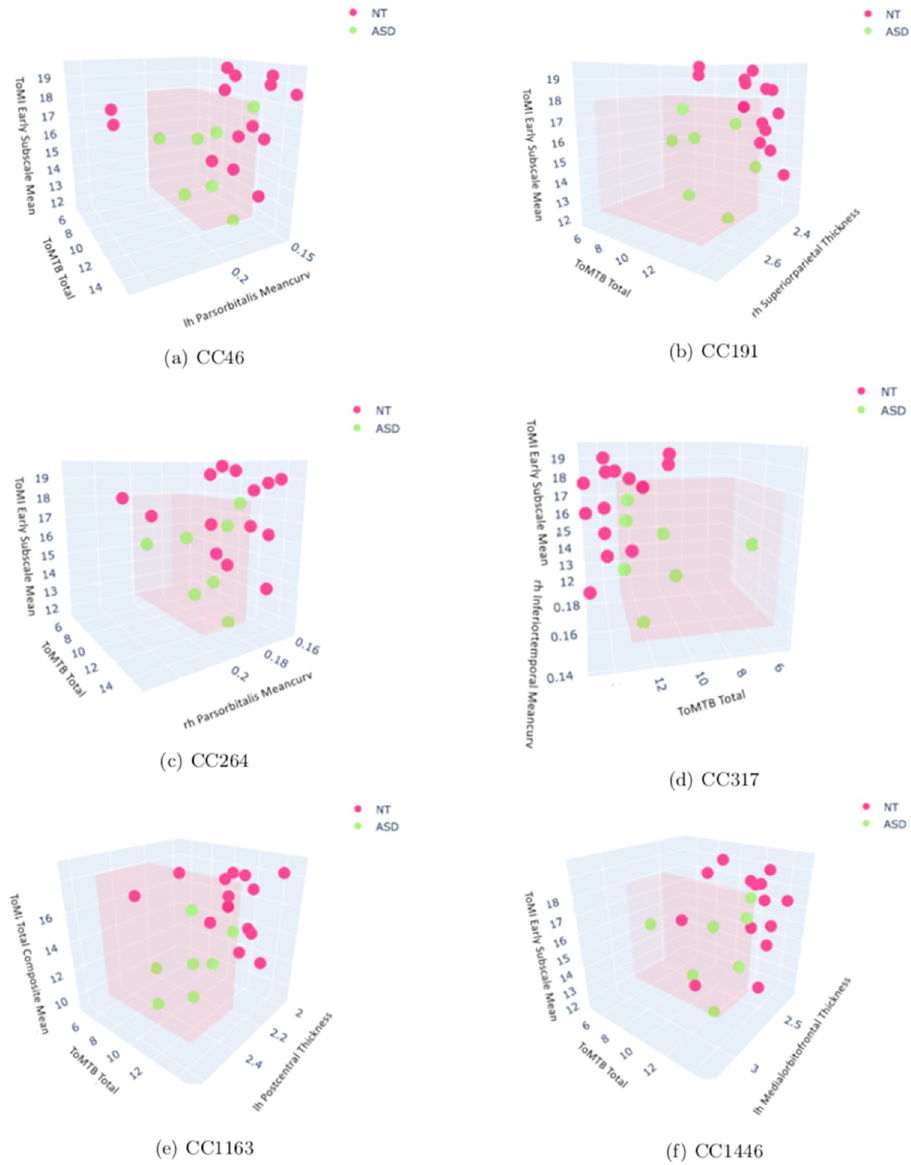
Fig 2. 3D visualization of third-order CC models. Green dots represent ASD subjects and group together within the pink cube defining the range of values in Table 4.